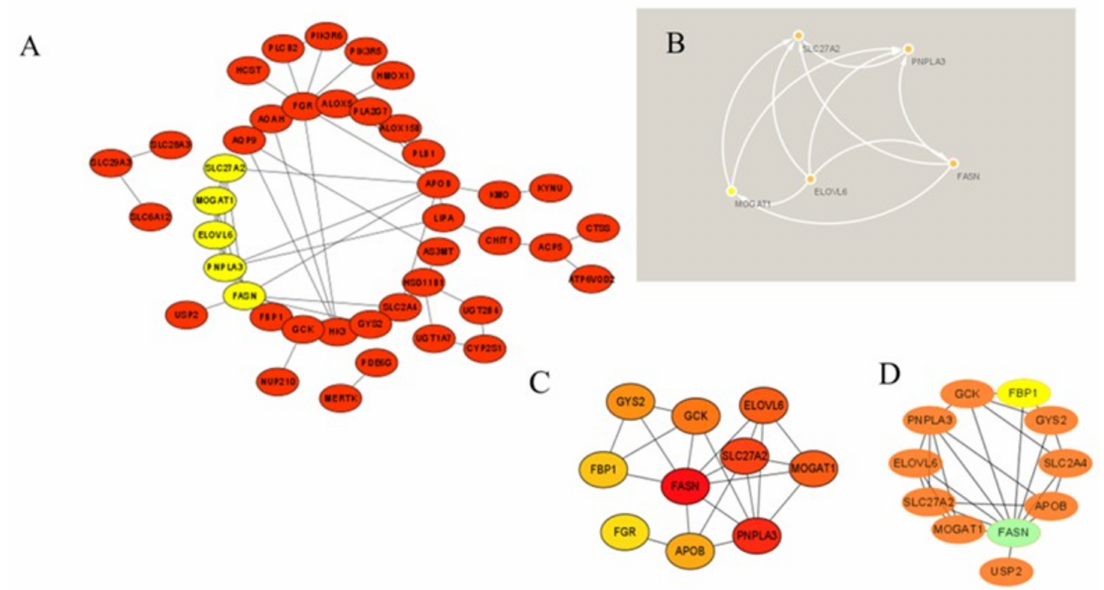
Figure 7. Protein − protein interaction (PPI) network of the differentially expressed genes of metabolism-related proteins (MP − DEGs) and screening of hub genes. ( A ) The STRING database was used to construct the PPI network of MP − DEGs, with 69 nodes and 72 edges. ( B ) The node gene cluster with the highest score, constructed using the MCODE plug-in in Cytoscape, consists of nine genes. ( C ) CytoHubba was used to construct the top 10 hub genes. The figure shows the top 10 hub genes constructed with the maximal clique centrality (MCC) method. ( D ) CytoHubba was used to predict the first − stop node genes that interact with FASN . In total, 10 genes were predicted, of which one was upregulated and nine were